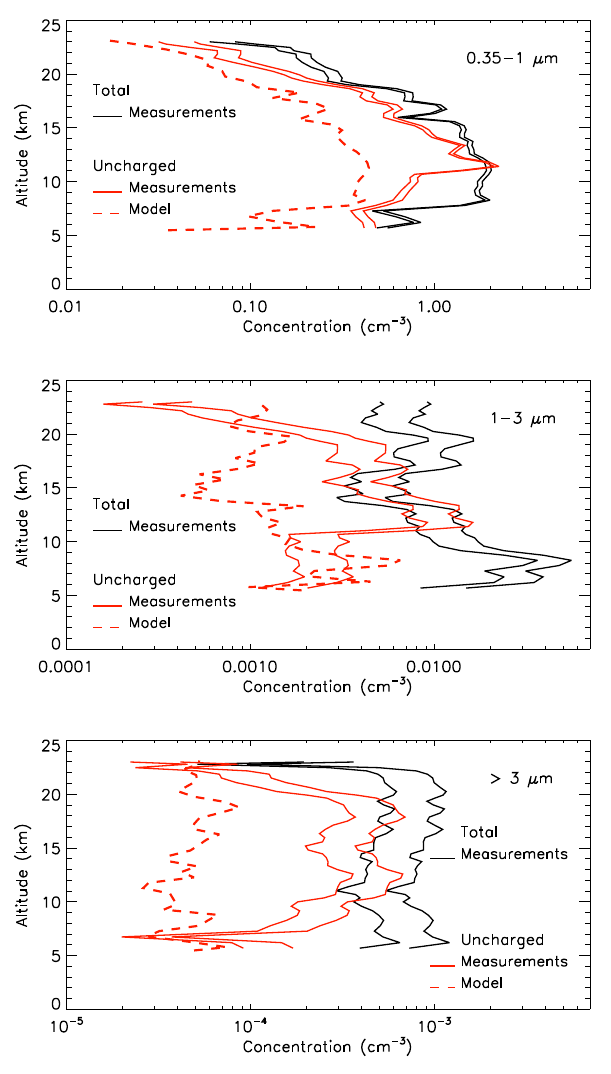
Fig. 5. Comparison between ascent measurements (solid lines) and modelling (dashed lines). The 2 measurement curves represent min- imum and maximum values taking into account the error bars. The altitude scale is given in km for comparison with the altitude scale in Figs. 1 and 2 given in hPa. The modelling data are constrained by the total concentration of aerosols measured by